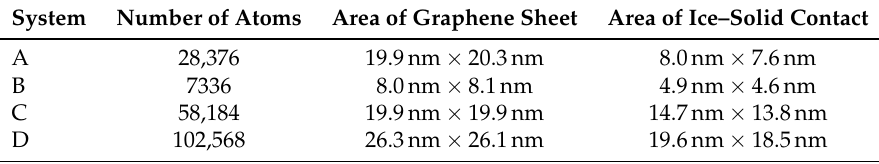
Table 2. Overview of the differently sized simulation systems. The different interaction energies ε in Table 1 were applied to all four systems to investigate water contact